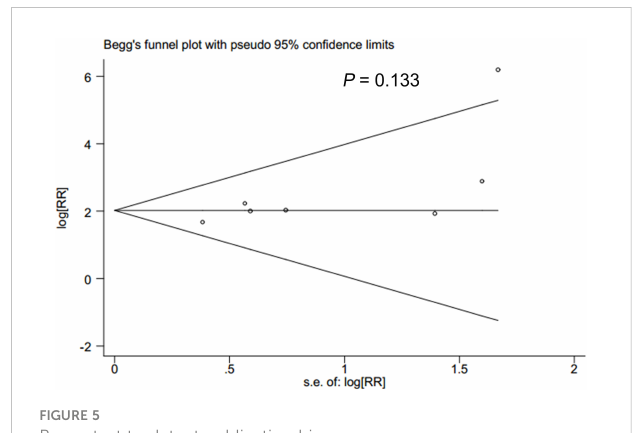
FIGURE 5 Beggs test to detect publication bias.